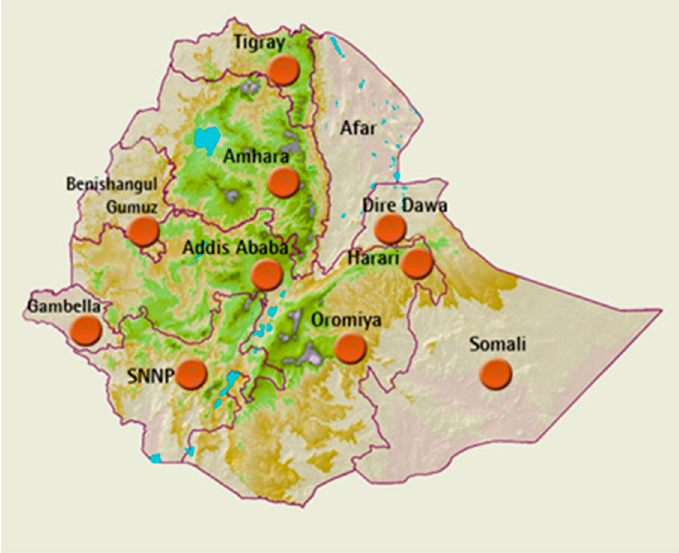
Figure 1. Microfinance institutions (MFI) distribution in Ethiopia. Source: association of Ethiopian MFIs (cited in a study by Babajide et al. 2015).